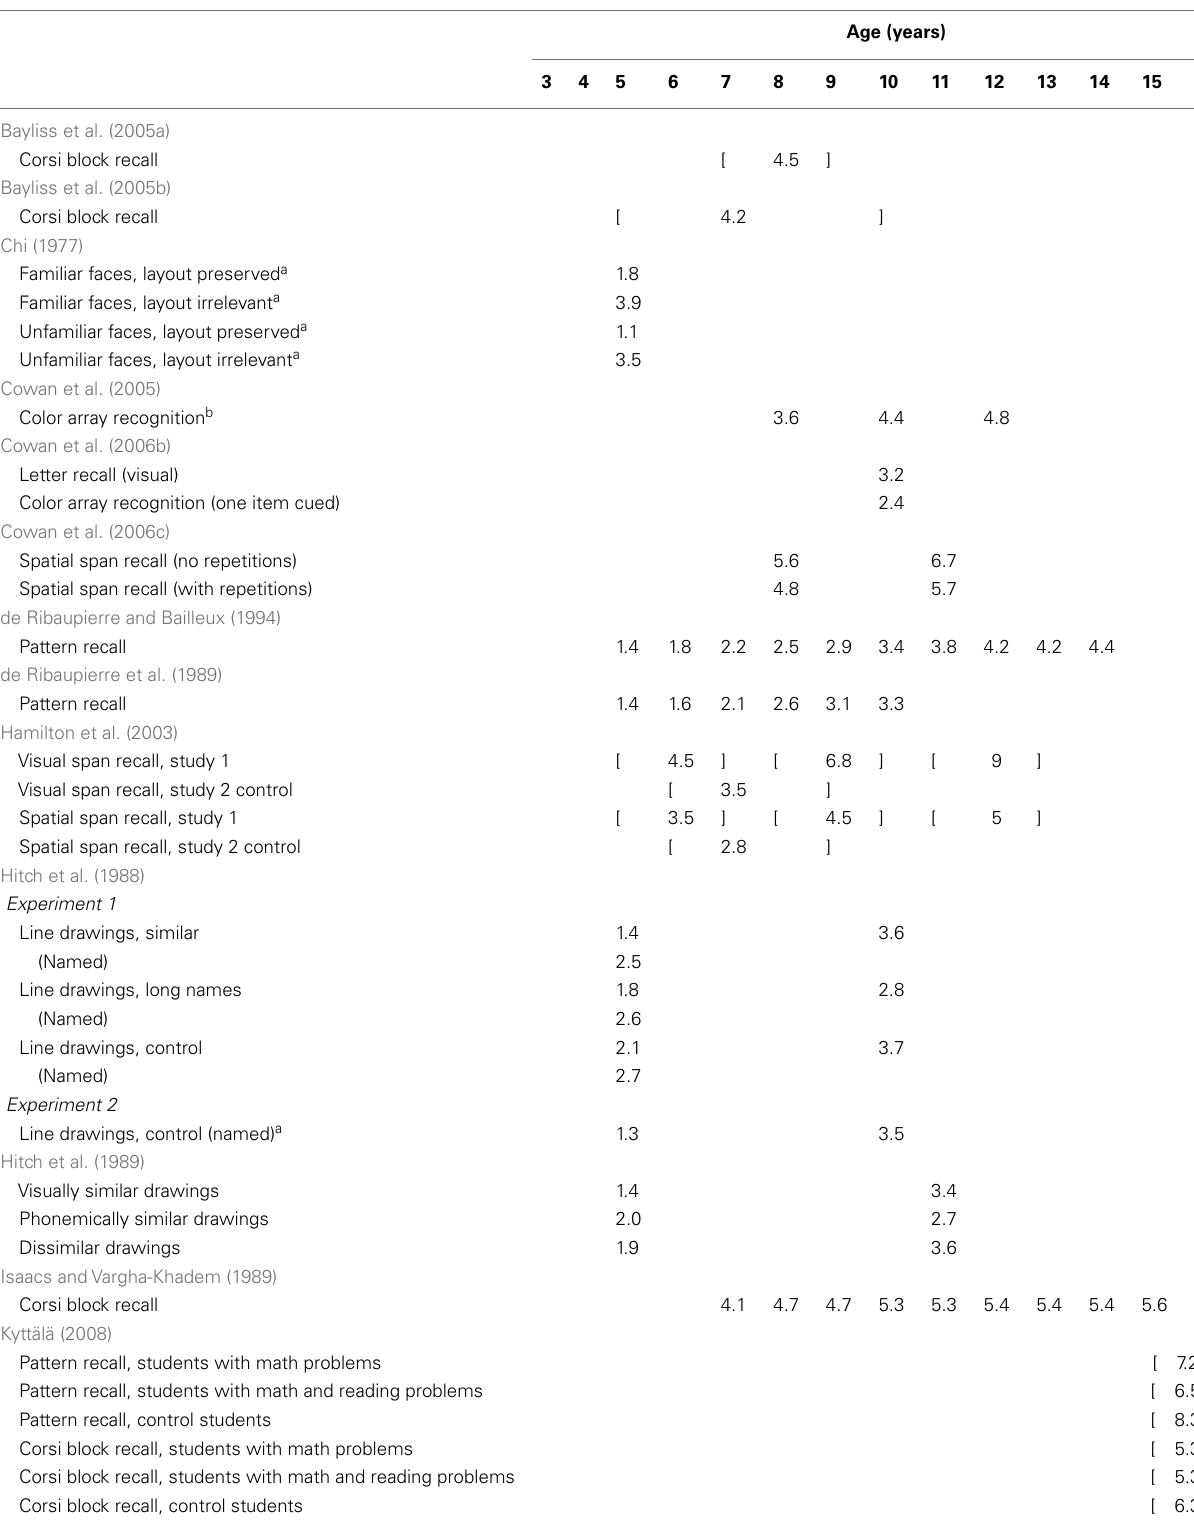
Table 2 | Estimates of visuo-spatial working memory capacity using simple span